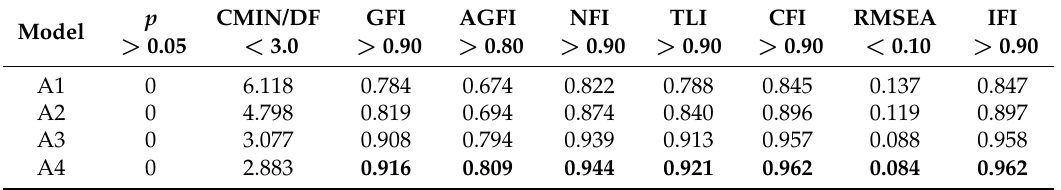
Table 3. The model fit summary for the structural model of online learning